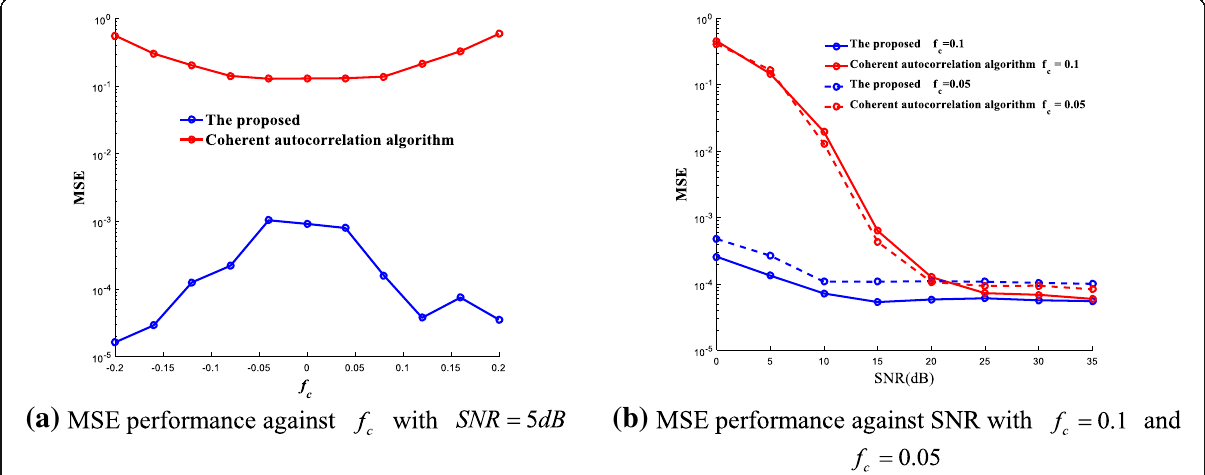
Fig. 4 The performance comparison of two CFO compensation schemes in 16 × 16 MIMO-OFDM